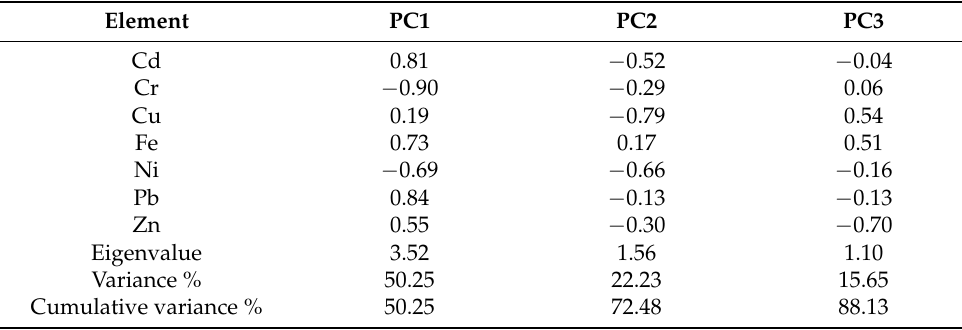
Table 3. Correlation coefficients between heavy metal contents. (* indicates significance at the significance level <0.05). Table 4. Factor loadings of elements and selected principal components (PC1, PC2,